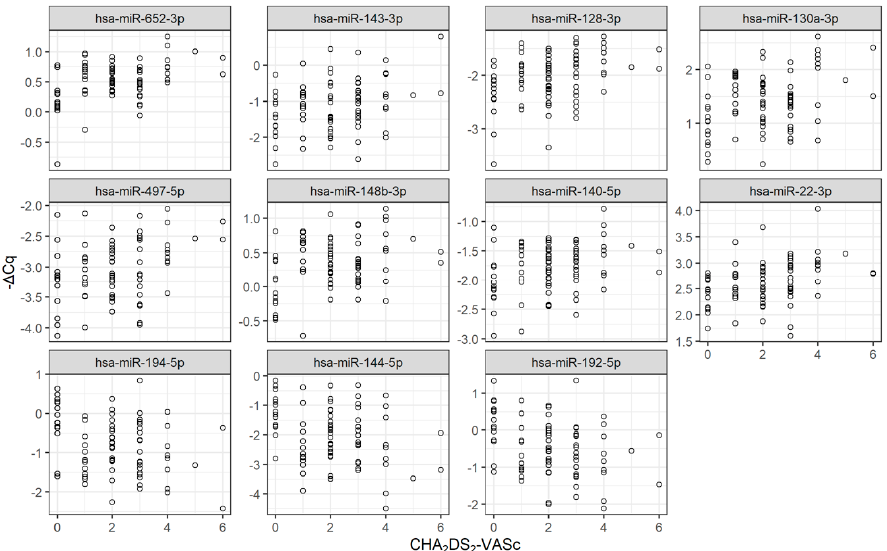
Figure 3. miRNAs associated with both CHA 2 DS 2 -VASc score and CA. Plasma levels (i.e., −∆ C q values) of 11 miRNAs, whose plasma levels showed correlations with both CHA 2 DS 2 -VASc score and CA operation, are presented as dot plots. X and Y axis represent plasma level ( − ∆ Cq value) and CHA 2 DS 2 -VASc score, respectively. Note that plasma levels of the miRNA are high when their − ∆ C q is high.